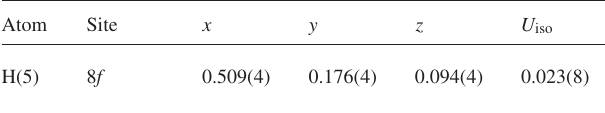
Table 2. Atomic coordinates and displacement parameters (in Å 2 )